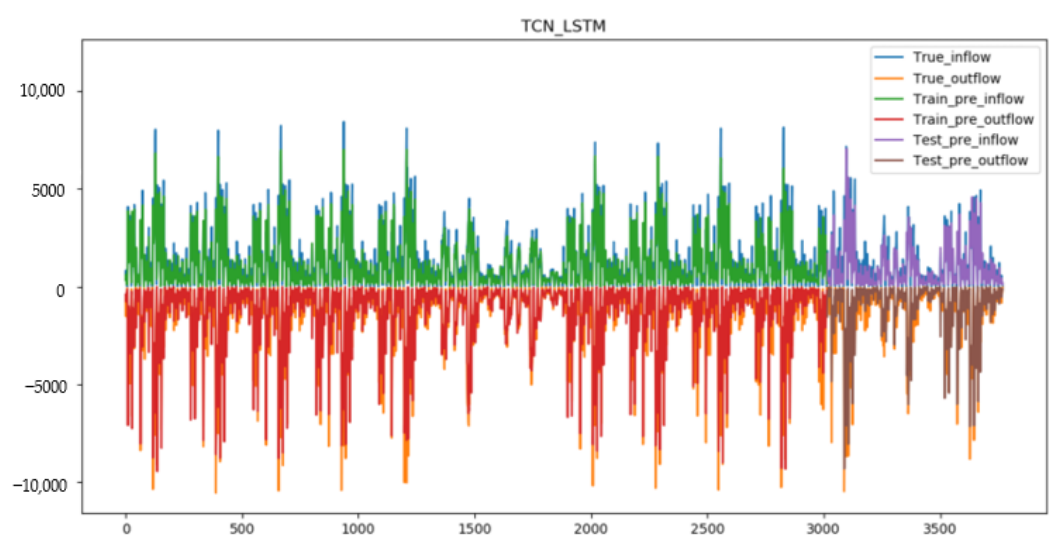
Figure 12. Prediction results of short-term passenger flow based on TCN-LSTM model.